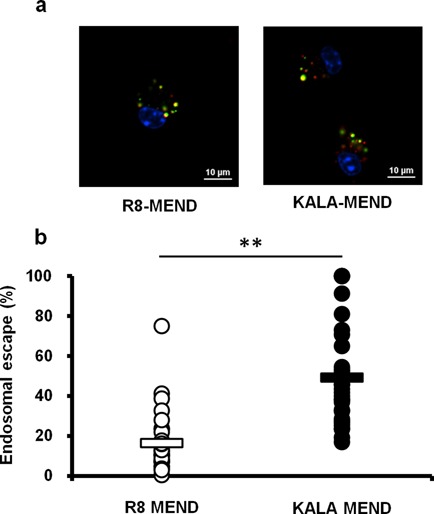
Quantifications of endosomal escape of KALA- or R8-MEND. BMCDs (4.0 × 105 cells) were transfected with the KALA- or the R8-MEND encapsulating QD705-pDNA (equivalent to 0.4-μg pDNA, QD705-pDNA was 50% of whole pDNA; red). (a) The BMDCs were observed by spinning-disc confocal microscopy at 6 h after transfection. The nuclei of cells were stained with Hoechst 33342 (blue) and acidic compartments were stained with Lysotracker® Green DND-26 (green) for 10 and 5 min before observation, respectively. Bars = 10 μm. (b) Quantification of endosomal escape of KALA- or R8-MEND. Endosomal escape rate was calculated by the following formula: ((1 − (yellow integrated pixel intensity/red integrated pixel intensity)) × 100). Each dot represents the calculated endosomal escape rate of respective cells. Bars show mean (n = 30). Statistical analysis was performed by Student's t-test. **P < 0.01.